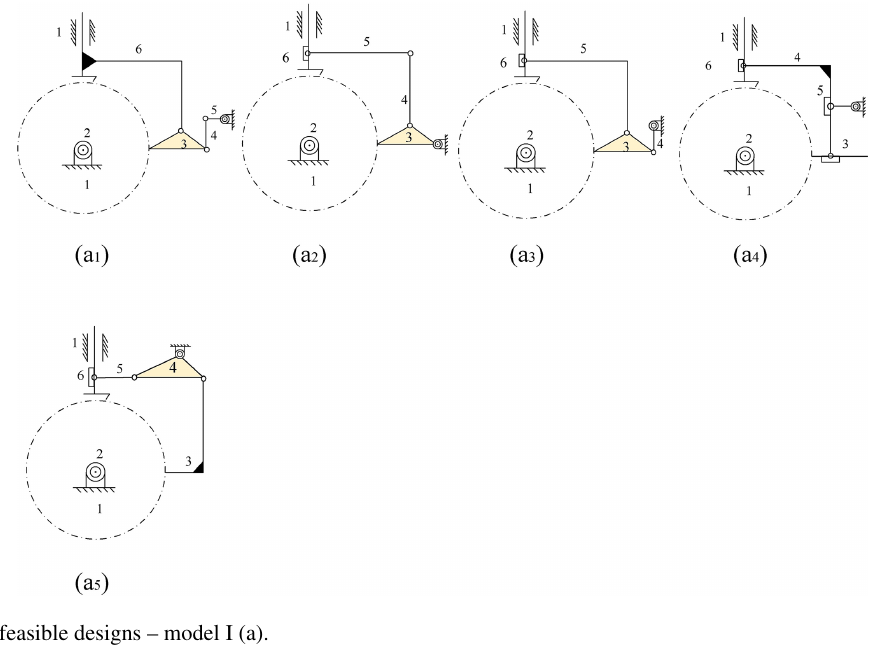
Figure 14. Atlas of feasible designs – model I (a).